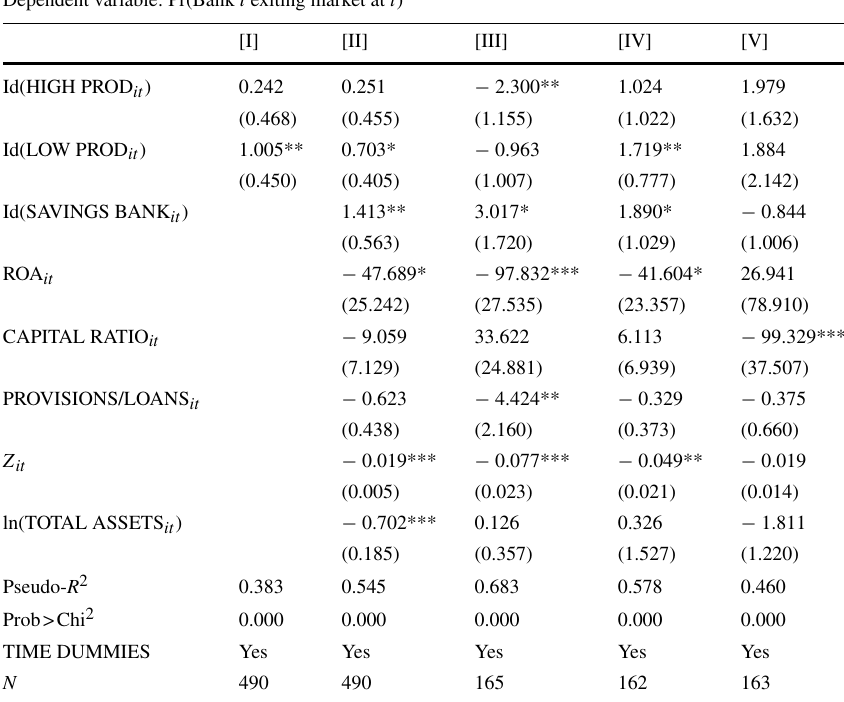
Table 4 Probability of exit of an entity Dependent variable: Pr(Bank i exiting market at t